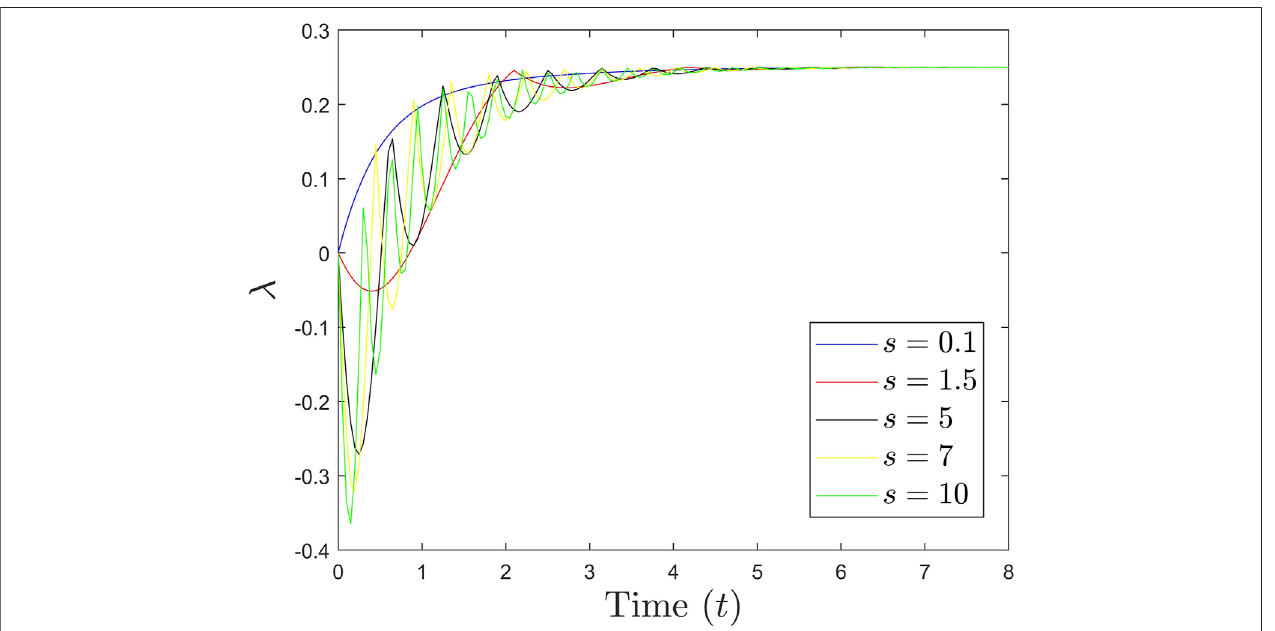
FIGURE1| (Coloroutline)Plotfortheeigenvalue λ vs.time(dimensionless).Notethatasthecouplingstrength s increases, λ assumesnegativevaluesoveracertain timescale,indicatingthatthequantumstatesofthetestmassesareentangledoverthistimescale.Forsmallvaluesof s ,theentanglementishardlyvisibleand/orevident [98 and